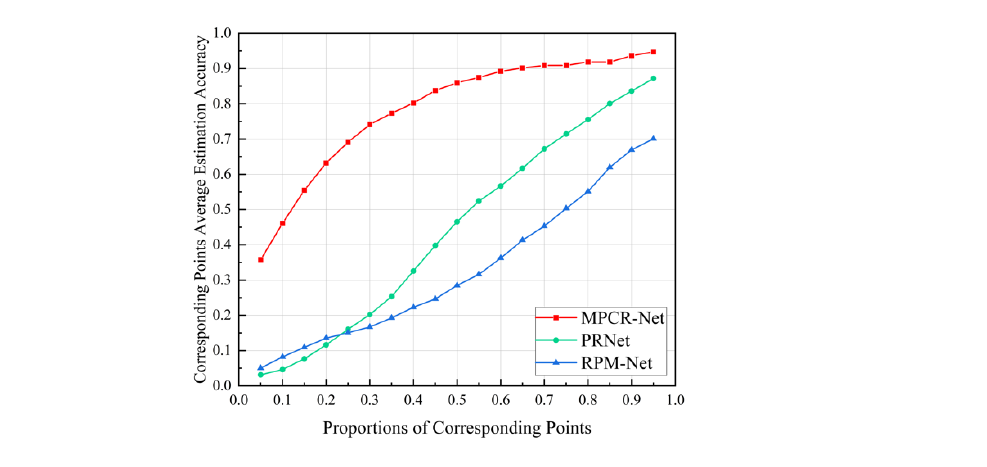
( c ) Figure 8. Accuracy of correspondence point estimation: ( a ) TPCC-Net, p = 0.90; ( b ) PRNet, p = 0.51; ( c ) RPM-Net, p = 0.25. The distribution of these estimated correspondence points and the initial partial point cloud (Figure 8c) in the global template point cloud were compared. The closer two distributions are, the more correspondence points are correctly estimated, and the higher the estimation accuracy p of the correspondence point estimation. Under the condition that the proportion of correspondence points was 0.05 to 0.95, estimation experiments were performed on all models in the test set. Then, the average estimation accuracy of the correspondence point of the three algorithms was calculated. As shown in Figure 9, the average estimation accuracy of the corresponding points of the three algorithms increased as the proportion of correspondence points increased. However, as the proportion of correspondence points decreased, the accuracy gap between PRNet, RPM-Net, and MPCR-Net gradually widened. When the proportion of correspondence points was 0.95, the estimation accuracies of the correspondence points of the PRNet and RPM-Net were 26.0% and 8.0% lower than that of MPCR-Net,